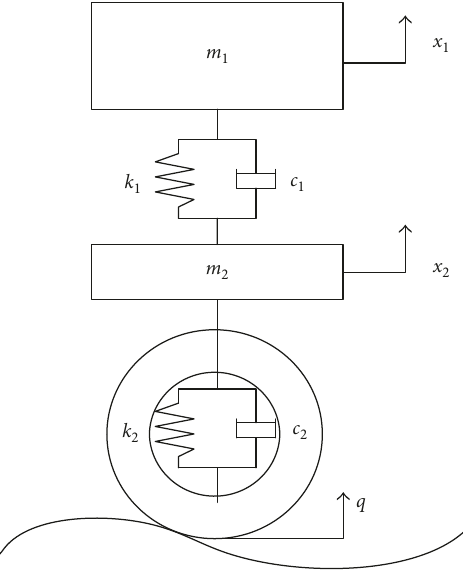
Figure 1: The quarter vehicle